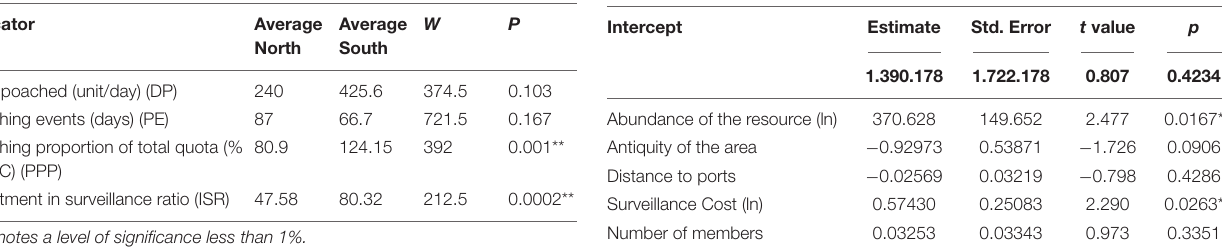
TABLE 4 | Multivariate regression model associated with the response variable “daily